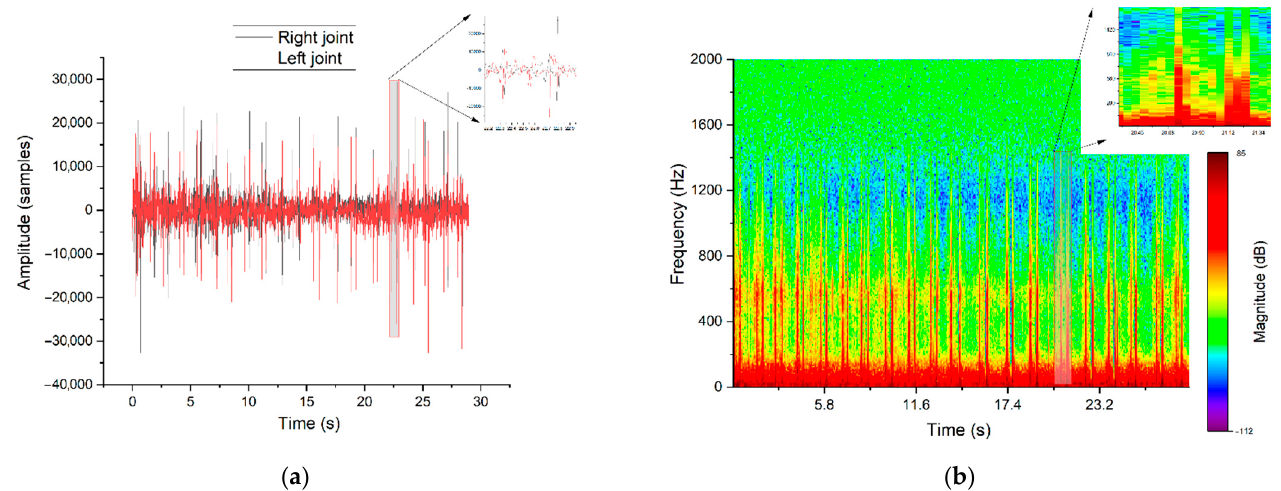
Figure 4. Signal traces recorded on both sides in time domain ( a ) and STFT representation of TMD manifested as clicks ( b )—representative parts of one jaw movement were magnified.